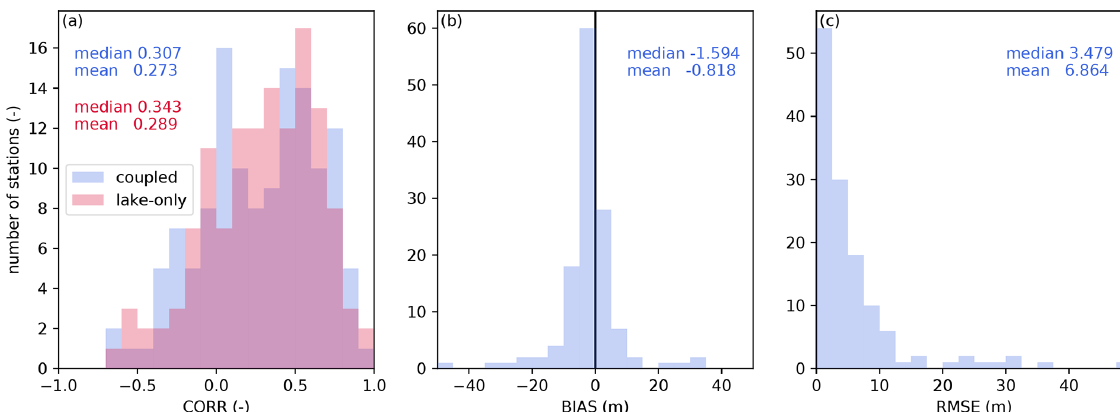
Figure 8. Comparison between reproducibility indices of lake surface elevation. Bars are the histogram of each index, and written values show the associated median and mean values. Blue (red) bars and writing show the results of the coupled (lake-only) simulation. Panel (a) shows CORR, panel (b) shows BIAS ( m ) , and panel (c) shows RMSE ( m ) .